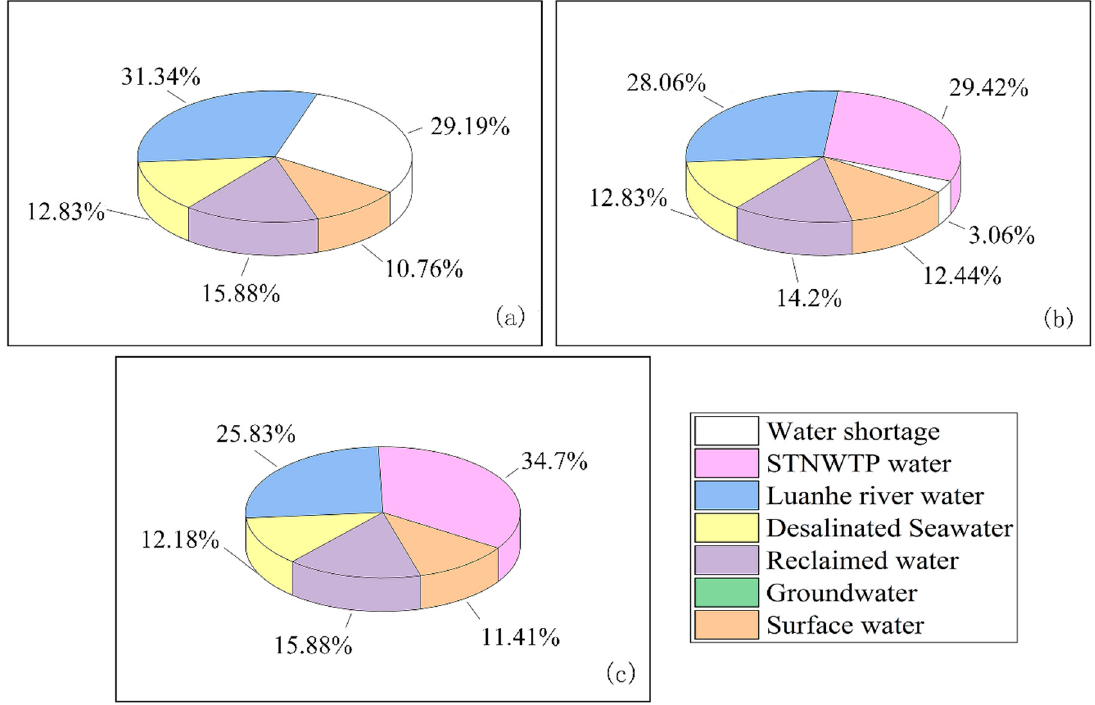
Figure 10. Distribution of water supply in Zhongxinchengqu and Binhaixinqu areas for: ( a ) (surface water 50% + Luanhe river water 75%); ( b ) (surface water 50% + Luanhe river water 75% + STNWTP water 95%); ( c ) (surface water 50% + Luanhe river water 75% + STNWTP water 75%).